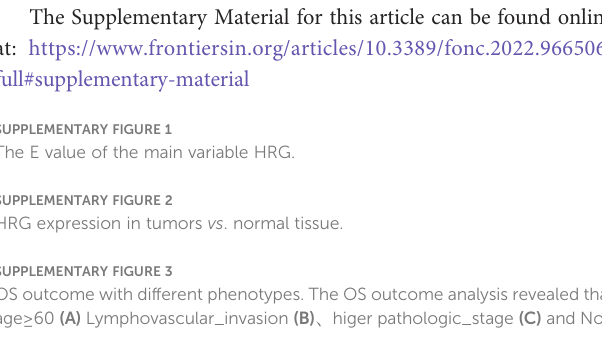
SUPPLEMENTARY FIGURE 2 HRG expression in tumors vs . normal tissue. SUPPLEMENTARY FIGURE 3 OS outcome with different phenotypes. The OS outcome analysis revealed that age ≥ 60 (A) Lymphovascular_invasion (B) 、 higer pathologic_stage (C) and Non